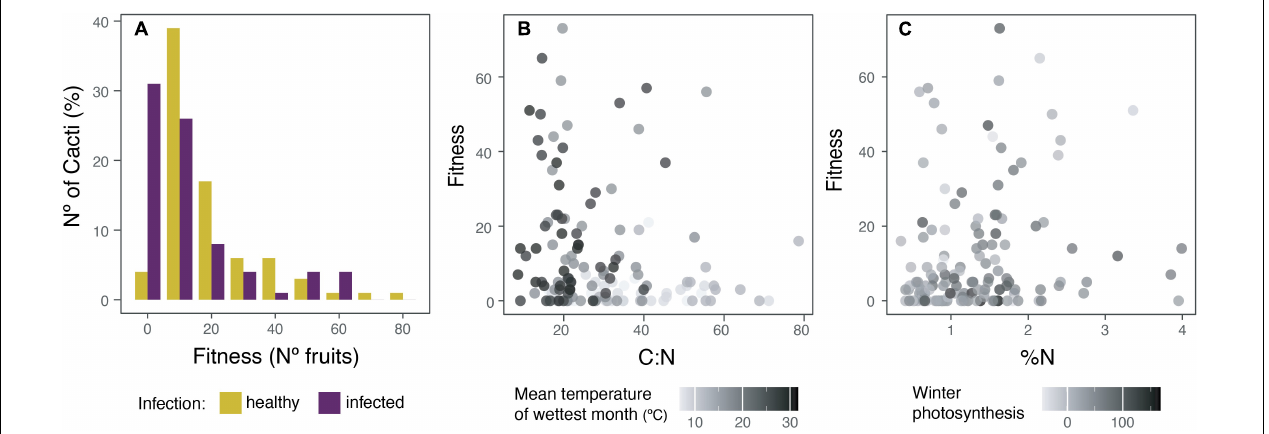
FIGURE 2 | The effect of the holoparasite Tristerix aphyllus and climatic conditions over fitness of its host Echinopsis chiloensis . Fitness, understood as the number of fruits produced, was better explained in a generalized linear mixed Poisson model (marginal R 2 = 0.28, conditional R 2 = 0.37, AICc = 2102.9) by: infection, the amount of nitrogen on the cortex (%), winter photosynthesis, carbon to nitrogen ratio, and precipitation of the wettest quarter. (A) Percentage of healthy (yellow) and infected (violet) cacti producing a specified number of fruits, assuming the same total number of cacti for each. (B) Relation of C:N ratio and mean temperature of wettest month with fitness. (C) Relation of nitrogen content (%N) and winter photosynthesis with fitness.